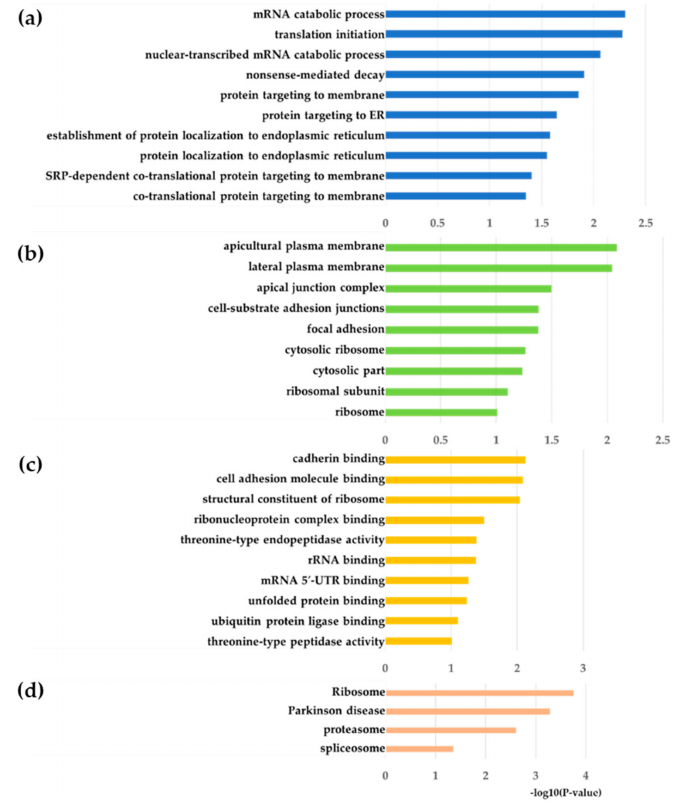
Figure 6. Gene ontology and pathway enrichment analysis of blue module genes. X -axis reveal the − log10 ( p -value). ( a ) Cellular component analysis. ( b ) Biological process analysis. ( c ) Molecular function analysis. ( d ) KEGG pathway analysis.